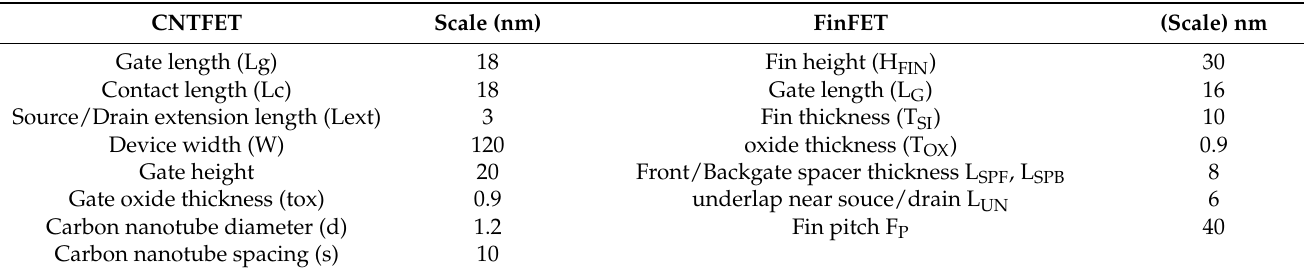
Table 2. Geometric parameters of the 14-nm carbon nanotube field-effect transistor and FinFET.